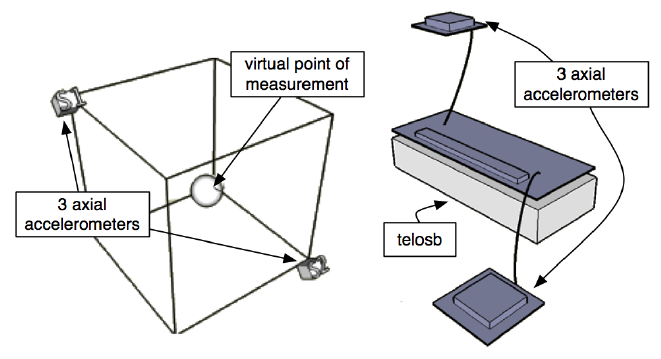
Figure 2. Diagram of the accelerometers position.